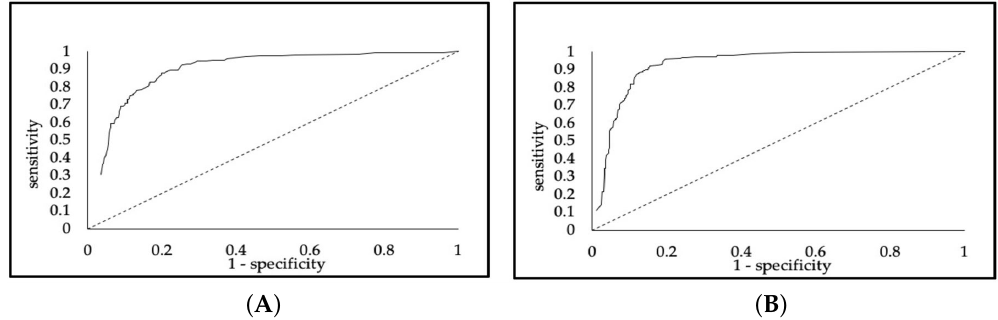
Figure 13. ROC curve results of the sugarcane area classification model. ( A ) ROC curve results of model 1 and ( B ) ROC curve results of model 2.